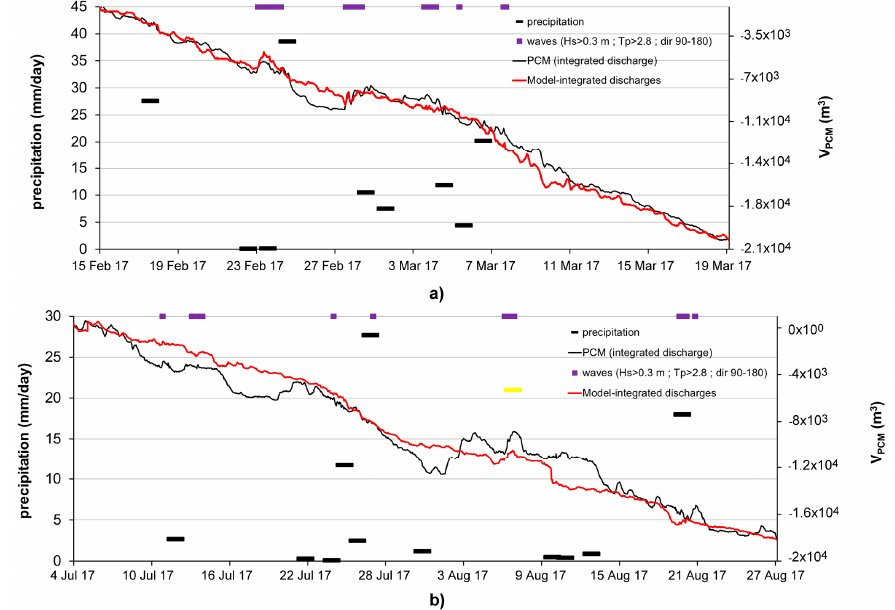
Figure 15. Comparison of the measured integrated discharge and modeled integrated discharge for ( a ) winter measurement period and ( b ) summer measurement period.